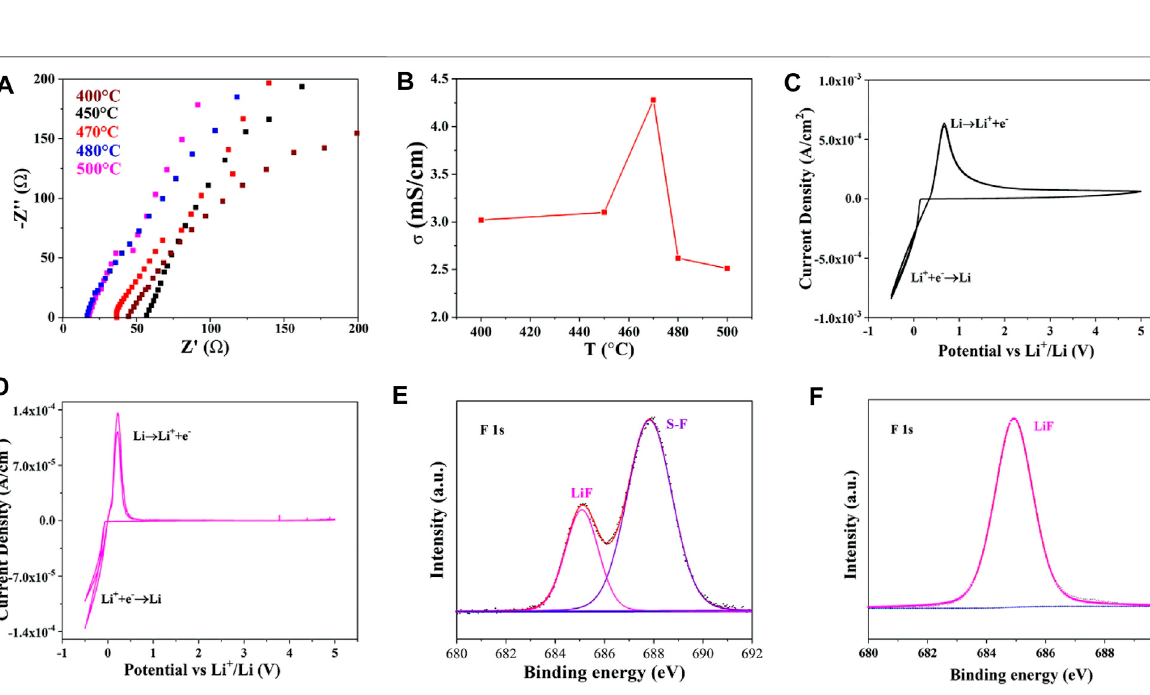
FIGURE 2 | SEM images of Li 10.35 Si 1.35 P 1.65 S 12 synthesized at 400 ° C (A,B) , 450 ° C (C,D) , 470 ° C (E,F) , 480 ° C (G,H) , and 500 ° C (I,J) .